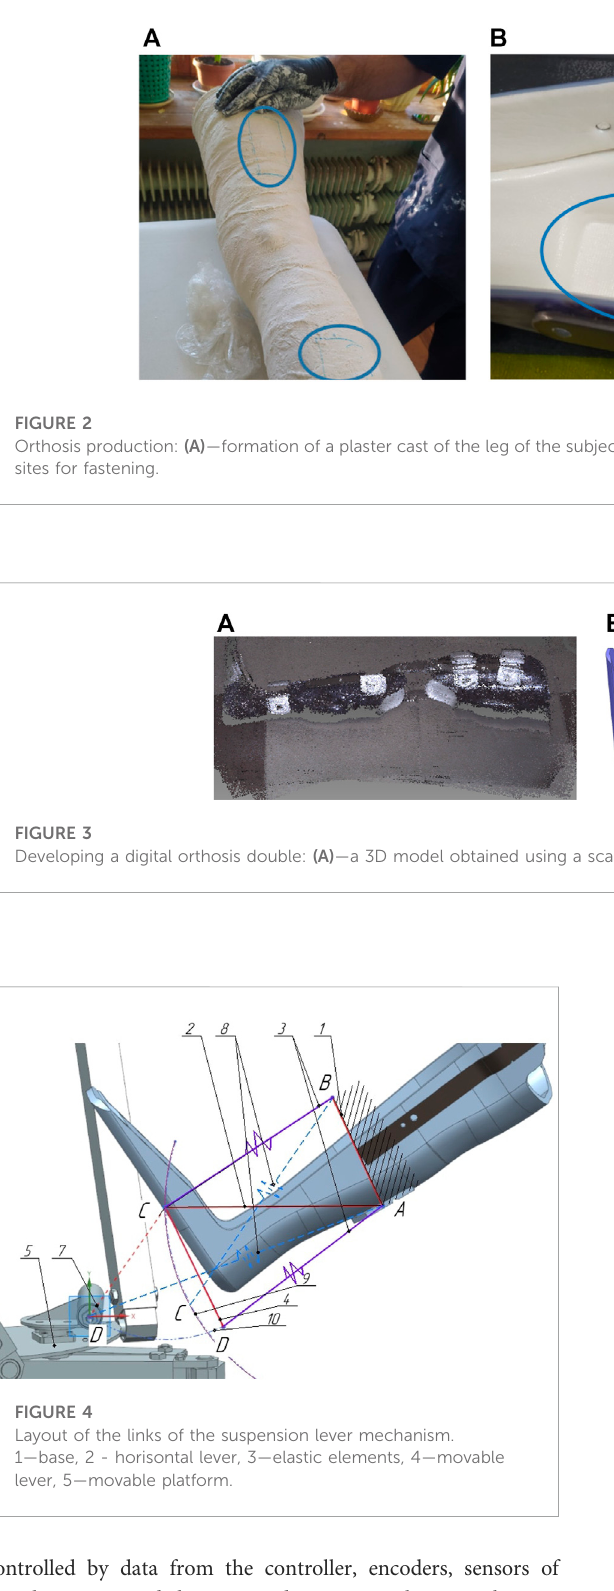
controlled by data from the controller, encoders, sensors of muscle activity and the proposed suspension lever mechanism